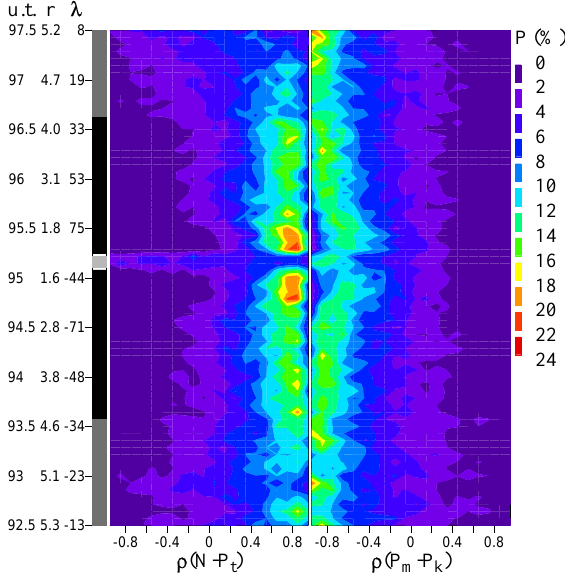
Fig. 2. Solar rotation histograms of ρ ( N − P t ) and ρ(P m - P k ) (left and right panel, respectively) are shown for the interval from mid-92 to mid-97. The vertical bar on the left indicates polar (black), mid- latitude (gray), and low-latitude (light gray) phases (as in Fig. 1). Time, distance (in a.u.), and latitude (in degrees) are given on the left (u.t., r , and λ , respectively). The colour code for the occurrence frequency P (in per cent) is shown on the